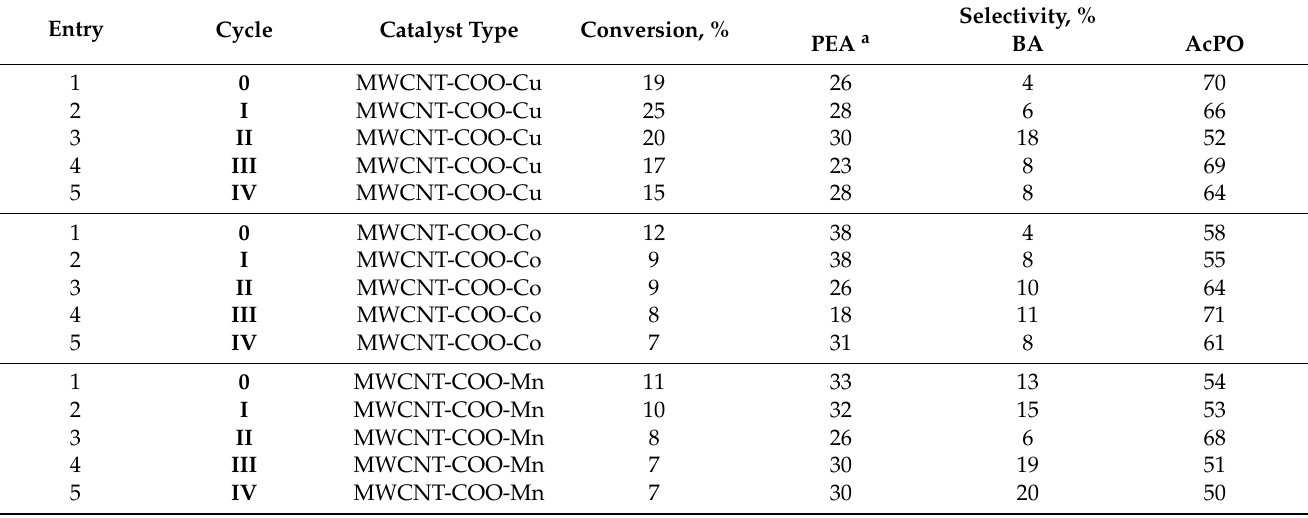
Figure 6. The conversion of ethylbenzene in subsequent reaction cycles. Ethylbenzene 80 mmol, NHPI 0.5 mol%, 80 ◦ C, 6 h, 1200 rpm, MWCNT-COO-M cycle 0: 0.125 g. Table 2. The selectivity of oxidation products with MWCNT catalyst recycling.